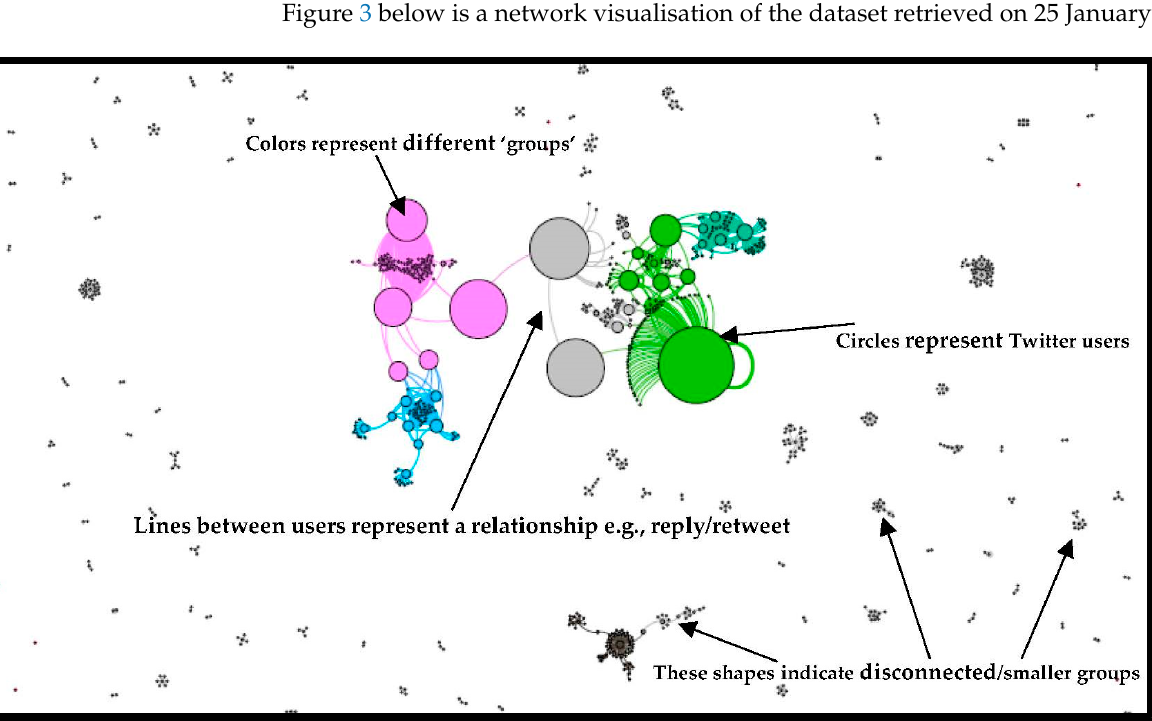
Figure 3. Network visual of 25 January 2022.